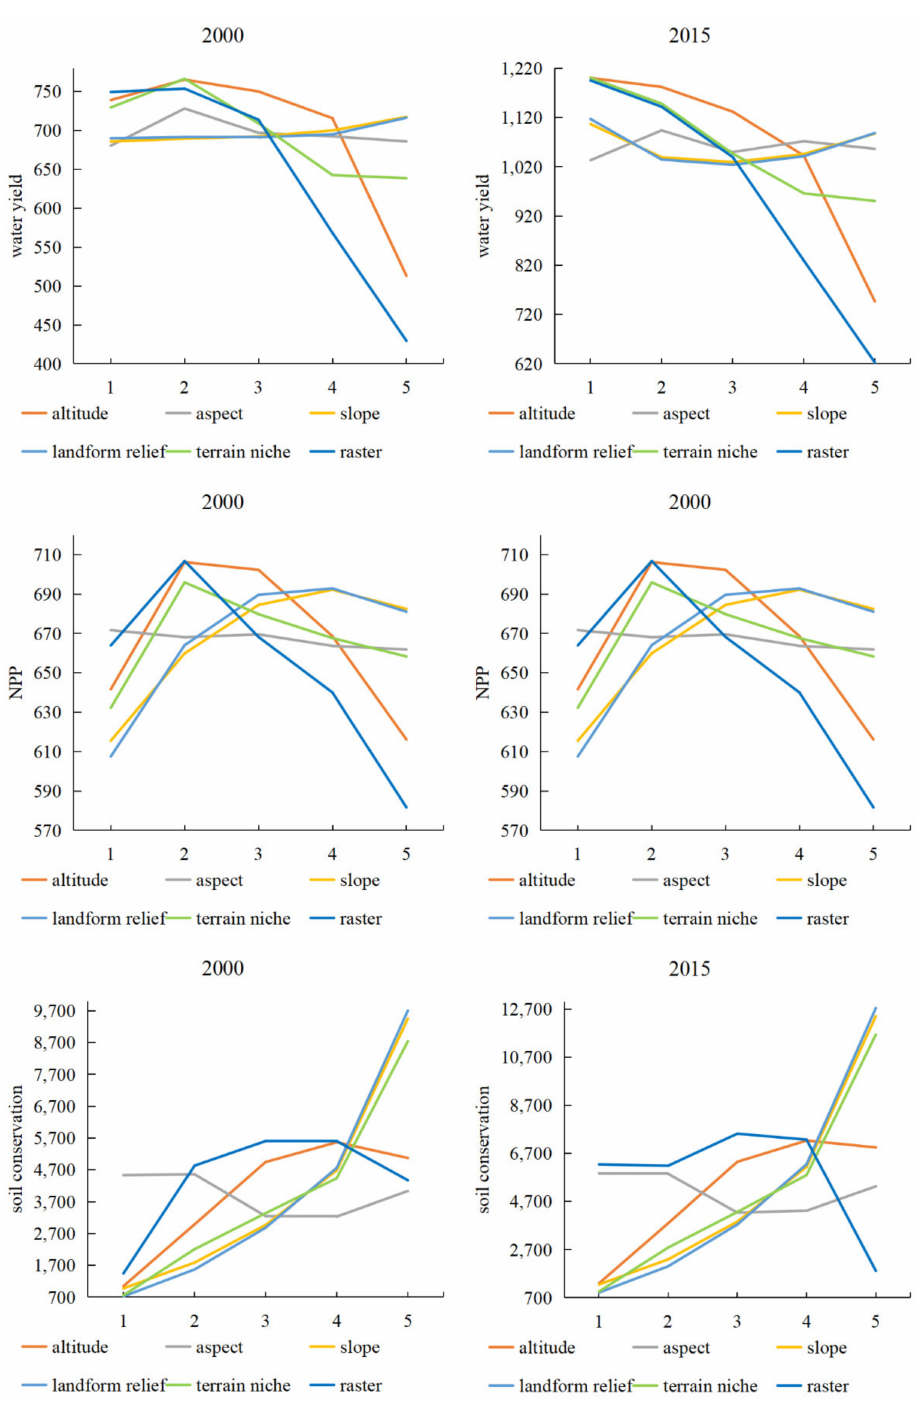
Figure 5. Differences ( p < 0.05) in the ESs in the terrain gradients and LHUs. NPP in 2000 increased at altitudes of 6–441 m and decreased at altitudes of 441–2861 m. Although the mean NPP in 2000 was very similar in different aspect zones, ANOVA indicated that the NPP in these regions was significantly different ( p < 0.05). NPP showed a consistent trend with increasing slope and landform relief in 2000, first increasing and then decreasing, reaching a maximum at slopes of 3.84 ◦ –6.05 ◦ (692.19 gC/m 2 ) and landform reliefs of 208–302 m (692.83 gC/m 2 ). NPP first increased and then decreased with